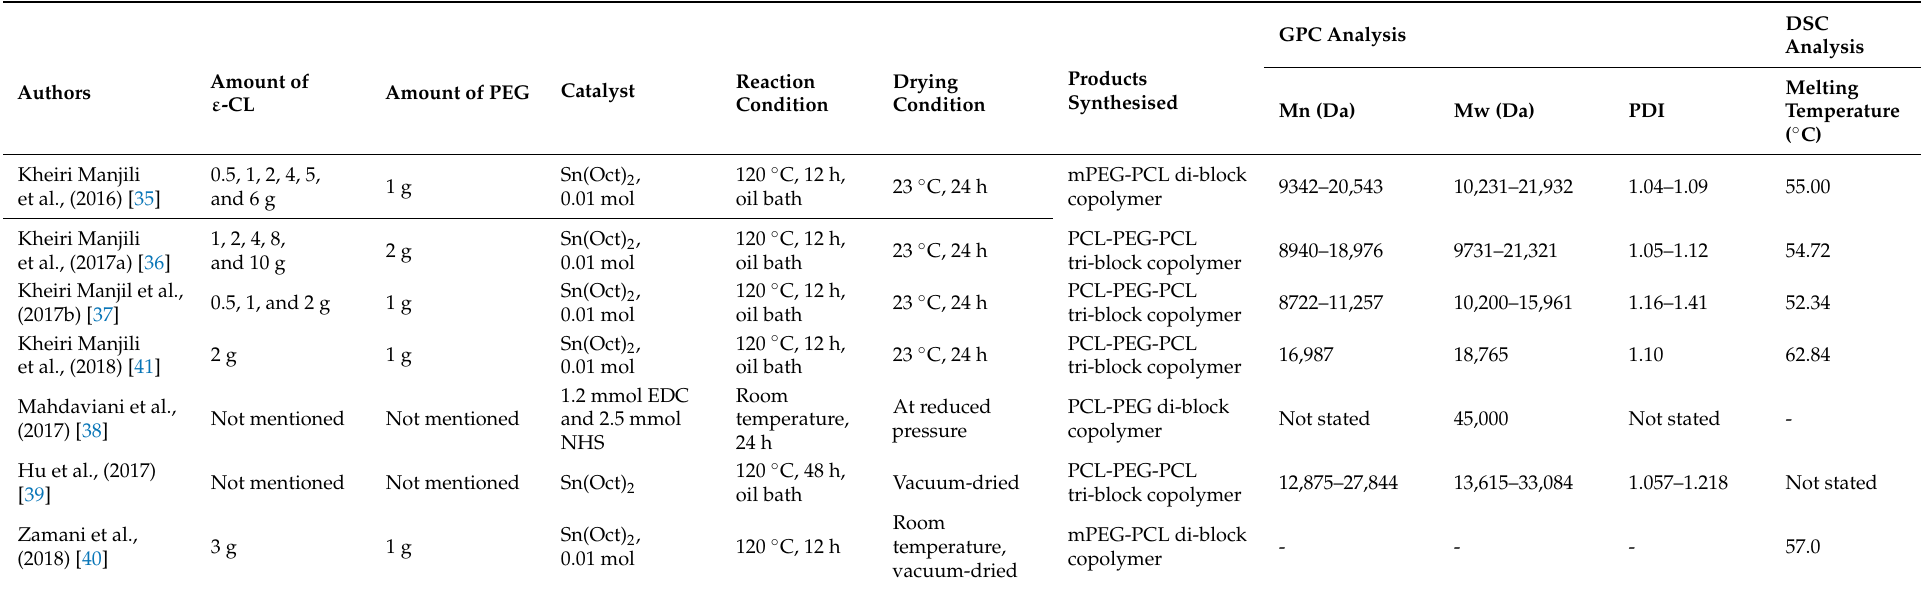
Table 4. Summary of data obtained from the synthesis and characterisation of PCL-PEG